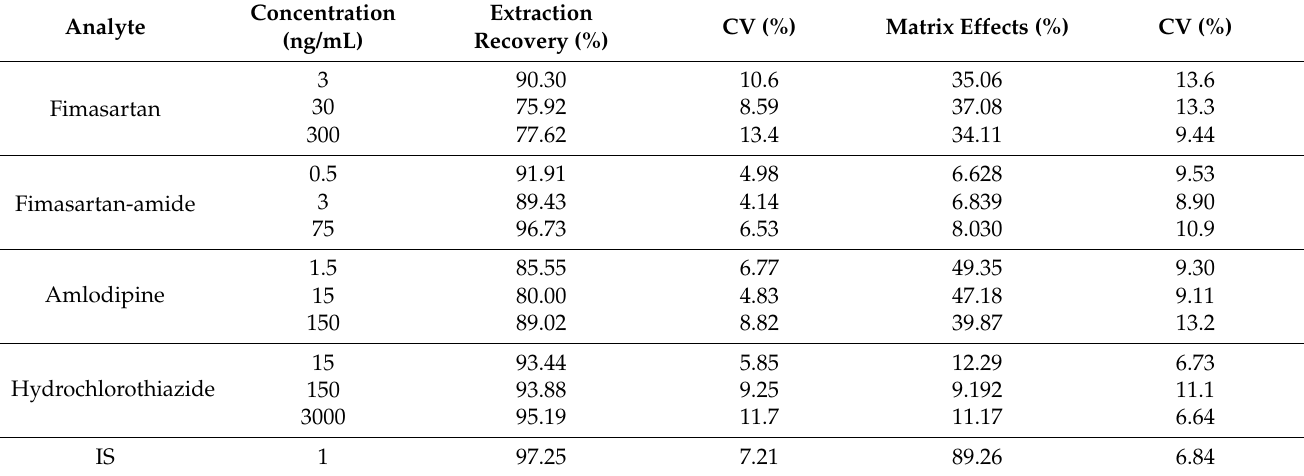
Table 3. Extraction recoveries and matric effects for the determination of fimasartan, fimasartan- amide, amlodipine, and